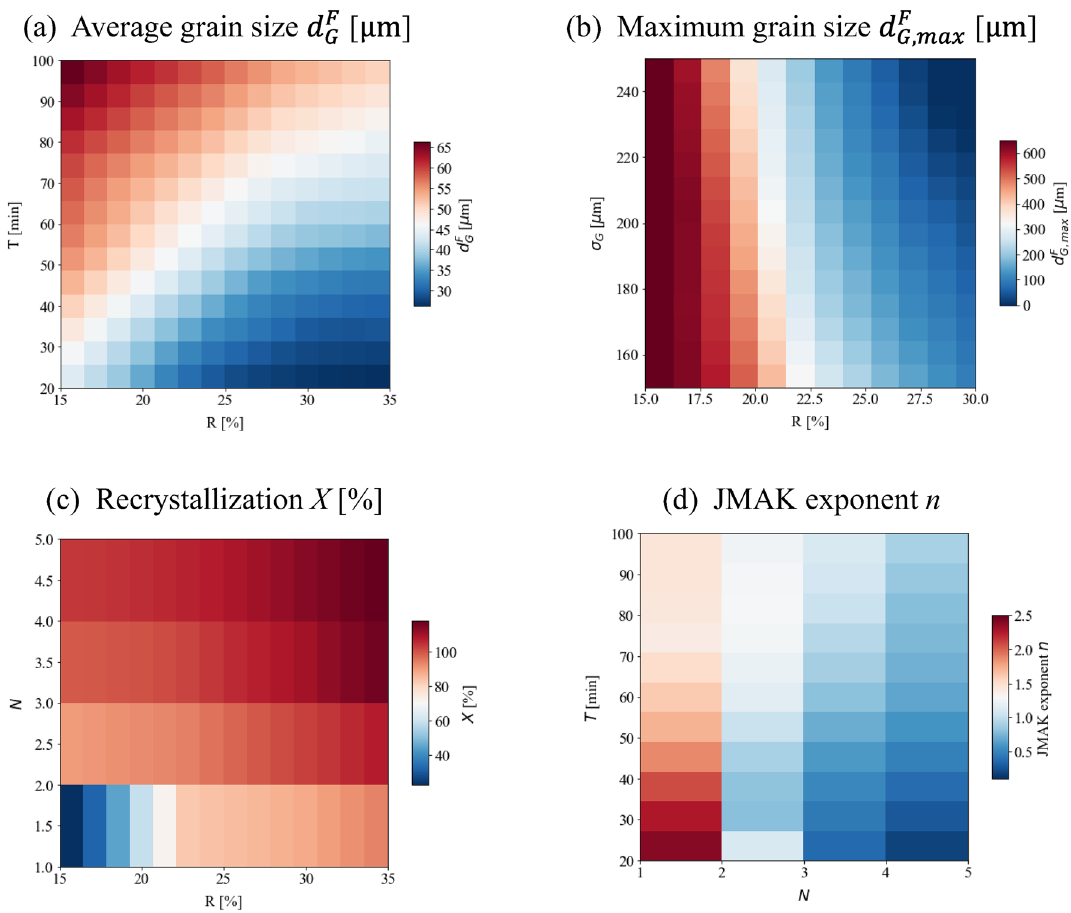
F d F G , max , ( c ) X , ( d ) JMAK exponent G , ( b )